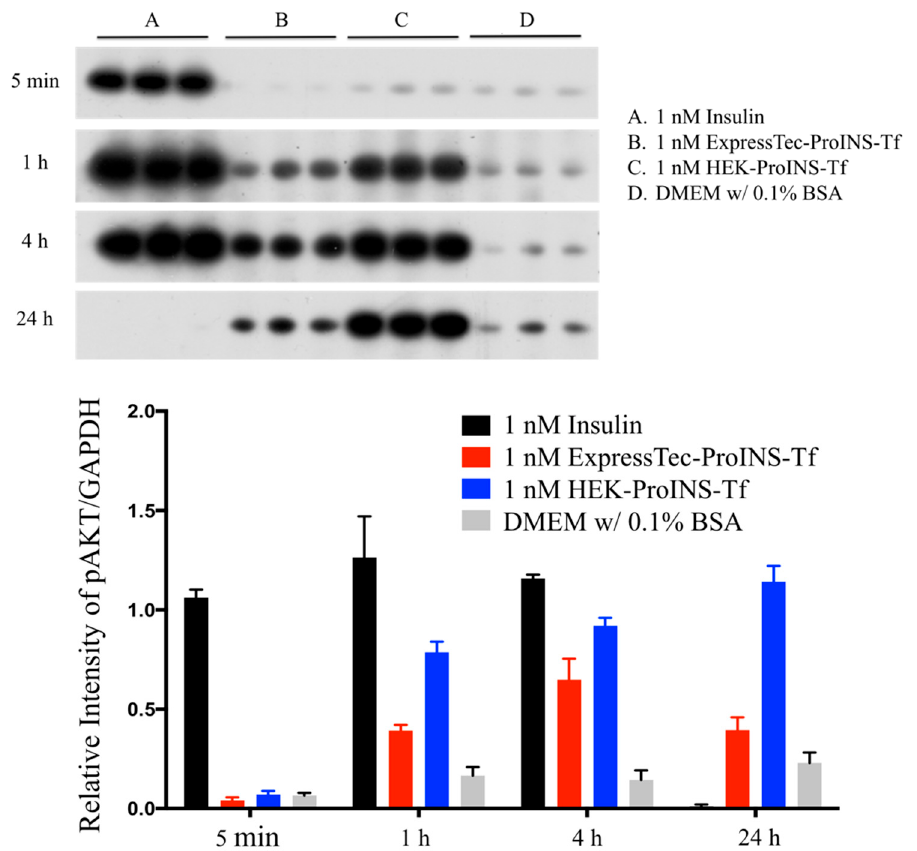
Figure 4. Stimulation of Akt phosphorylation in H4IIE cells. Serum-deprived H4IIE cells were treated with 1 nM of INS, ExpressTec-ProINS-Tf, HEK-ProINS-Tf or DMEM w /0.1% BSA at 37 °C for 5 min, 1 h, 4 h, and 24 h, respectively. After lysed with protein extraction buffer in the presence of protease and phosphatase inhibitors, 10 μ g of total protein were loaded to 10% SDS-PAGE and probed with anti-phospho-Akt antibody. The data were expressed as the intensity (mean ± SD) determined using Quantity One 1-D Analysis software (Bio-Rad, Hercules, CA, USA) with immunoblot using anti-GAPDH antibody as a loading control.